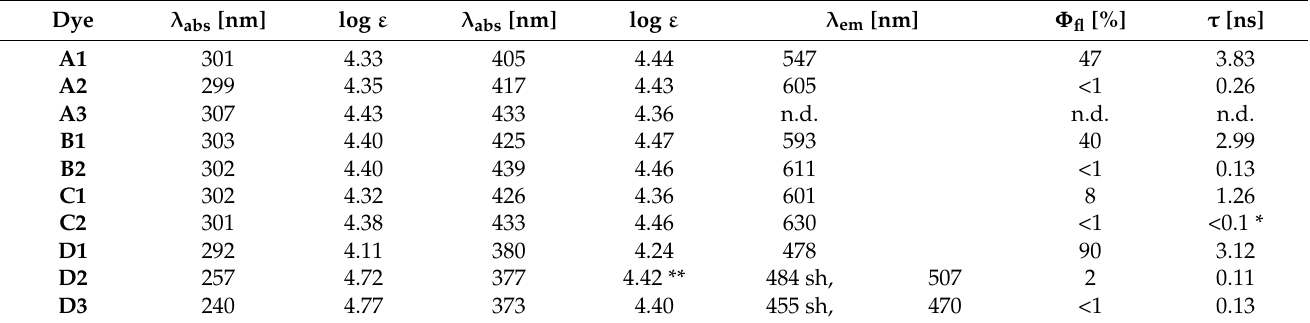
Table 6. Spectroscopic properties, in CH 3 CN at room temperature, of the synthesized dyes